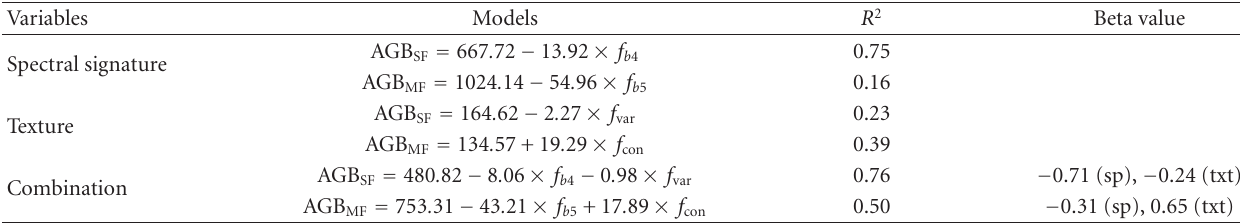
Table 1: A summary of regression analysis results in the western Brazilian Amazon.